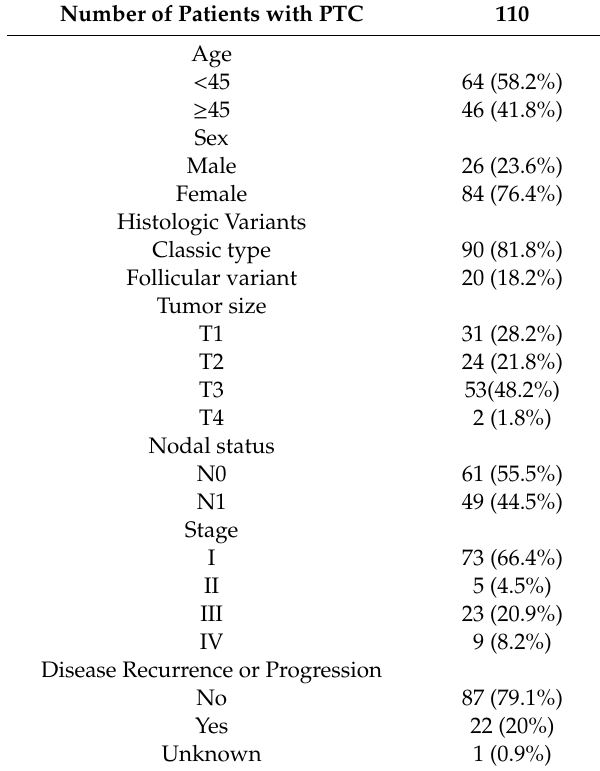
Table 6. Main clinico-pathologic data of PTC